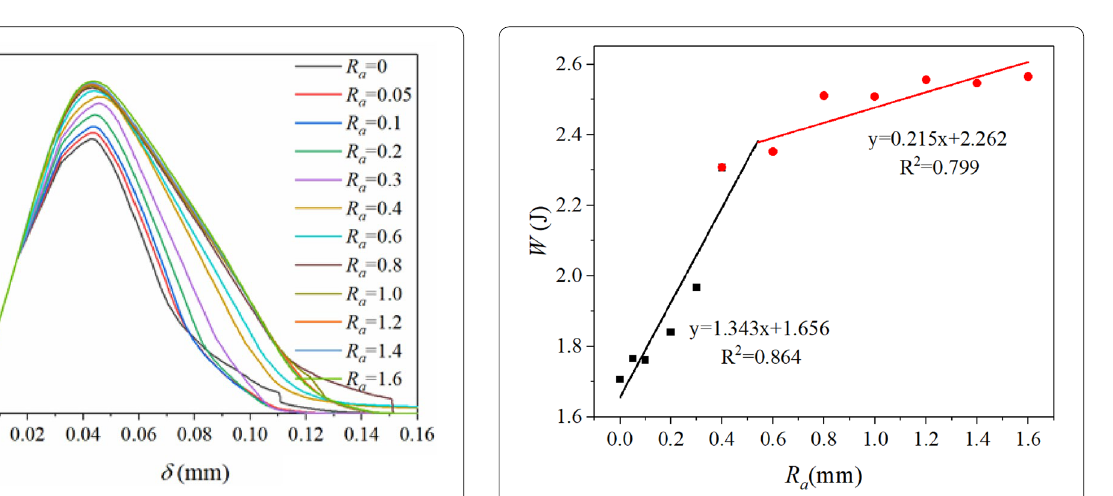
Fig. 16 Load–displacement curves for different aggregate surface roughness